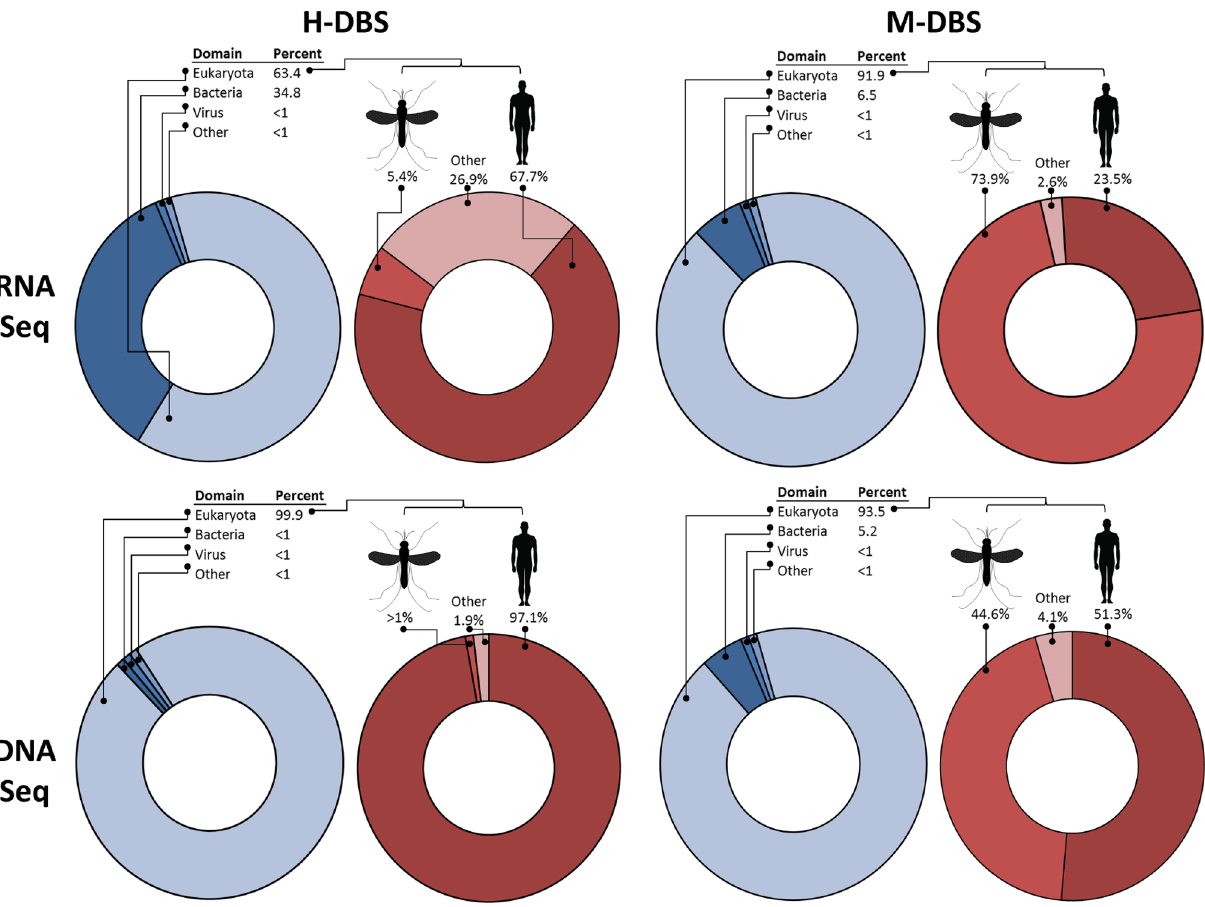
Fig 2. The majority of reads from M-DBS and H-DBS, for both RNA and DNA NGS pools, align to host nucleic acid. The taxonomic makeup of each sequencing pool was determined using the Blastn -Megablast tool with individual sequencing reads as input. Blue circles show taxonomic make up at the level of kingdom for all reads in each pool. Red circles show taxonomic makeup from a subset of reads aligning to eukaryotes. While the most reads in H-DBS aligned to human nucleic acid, reads from M-DBS aligned to both human and mosquito nucleic acid. Reads to human pathogens were detected in both H/M-DBS in the remaining